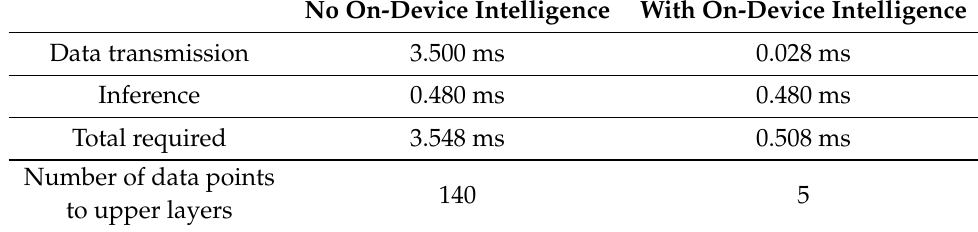
Figure 8. Custom BLE − enabled sensing module. ( a ) Block diagram, ( b ) prototype device to scale. Table 2. Tabulated summary of results